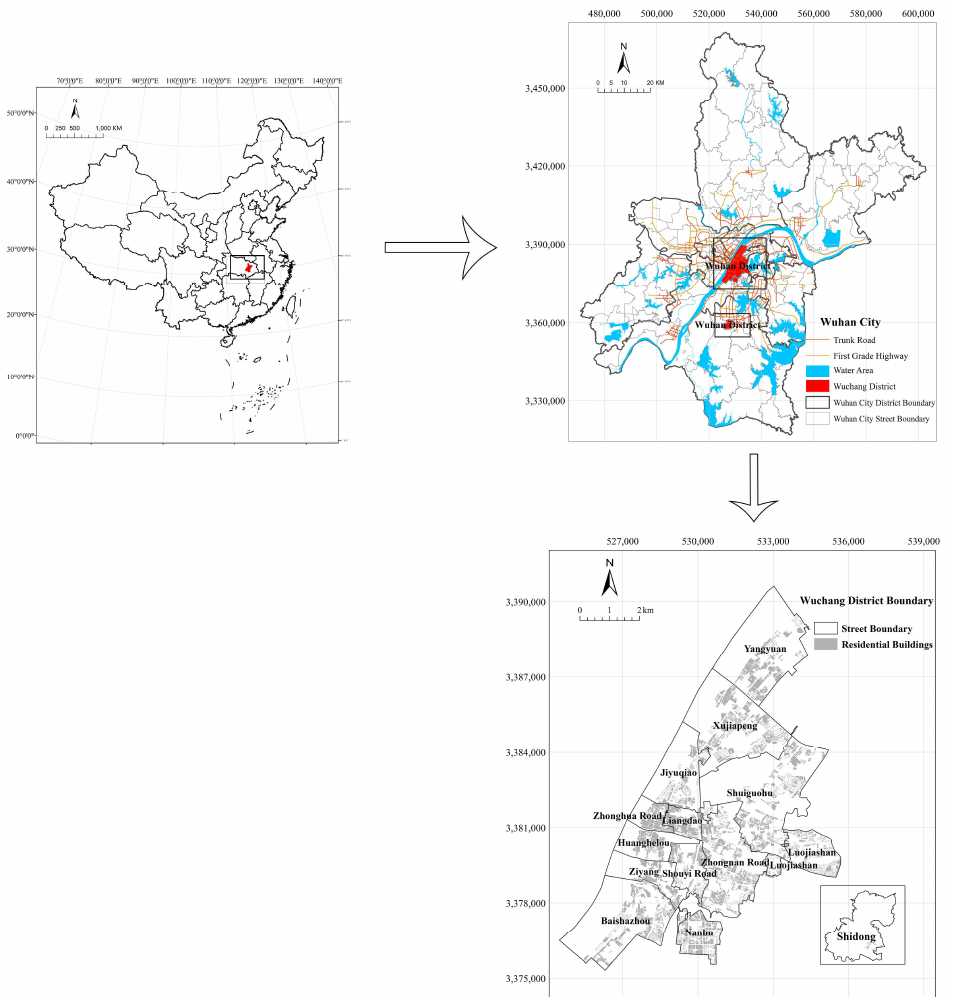
Figure 6. The Geographic Location of Wuchang District in Wuhan, China.